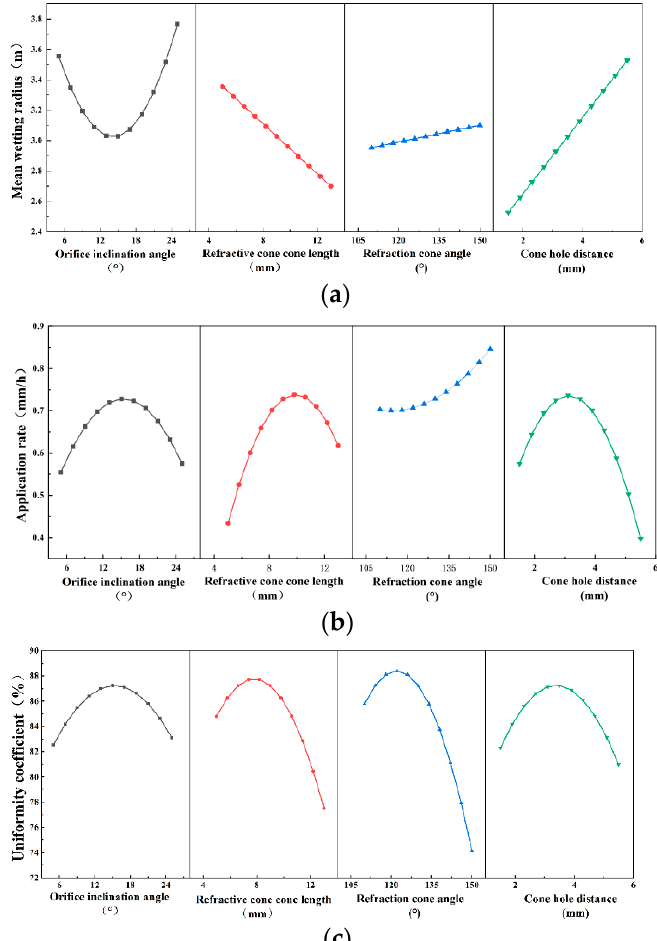
Figure 6. Main effect plot of irrigation performance. ( a ) Influencing factors of the wetted radius, ( b ) influencing factors of sprinkler application rate, ( c ) influencing factors of uniformity coefficients. Water 2023 , 15 , x FOR PEER REVIEW